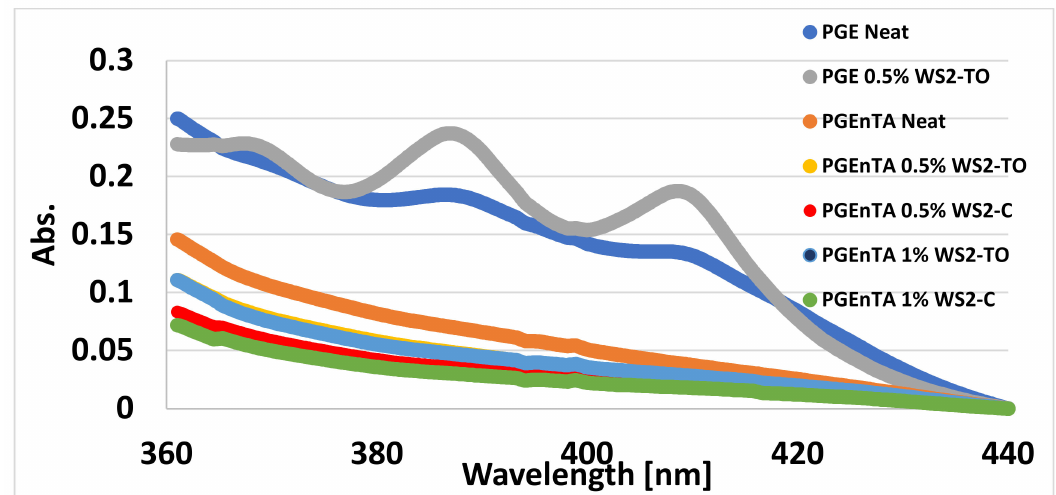
Figure 7. The absorption spectrum of selected cured epoxy/acrylate composite and neat formulations.